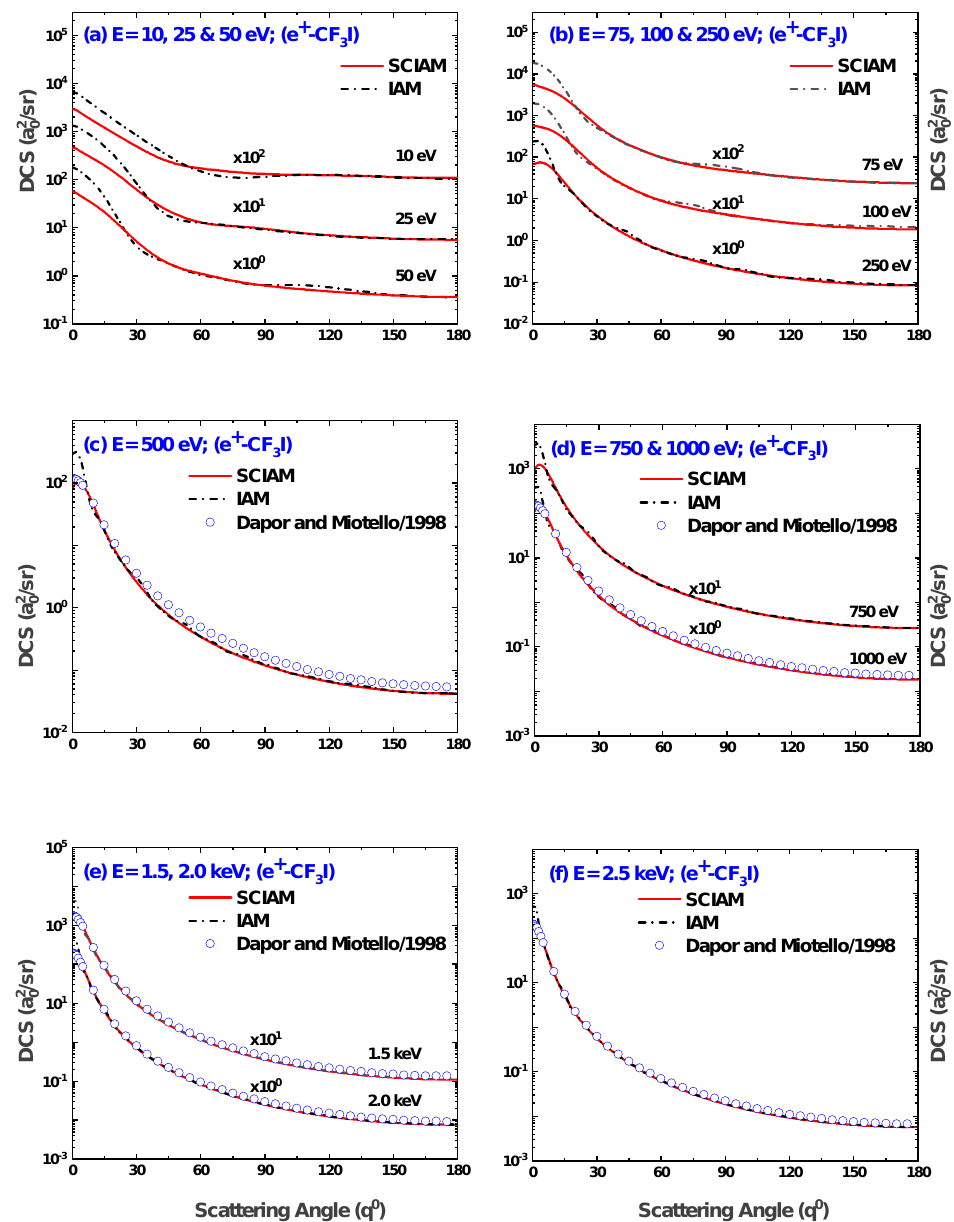
Figure 4. DCS ( a 2 / sr ) for the elastic scattering of positrons from CF 3 I at incident energies 10, 25, 50, 0 75, 100, 250, 500, 750, 1000, 1500, 2000, and 2500 eV. Theoretical works: SCIAM, IAM, and Dapor and Miotello